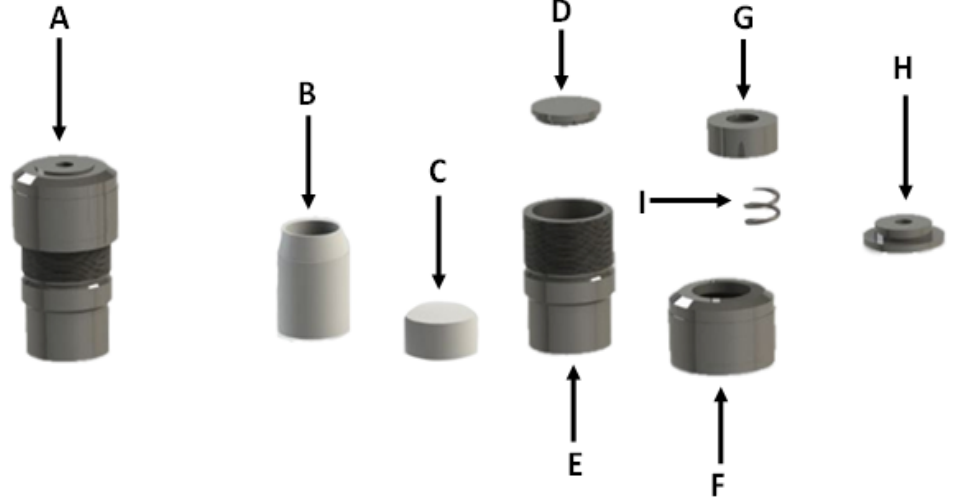
Figure 14. Parr bomb reactor assembly ( A ) Assembled reactor; ( B ) Teflon lining; ( C ) Teflon lid; ( D ) Bottom metal plate; ( E ) Metal casing; ( F ) Metal lid; ( G ) Metal weight keeping teflon lid in place; ( H ) Top metal plate; ( I ) Spring separating metal weight and top